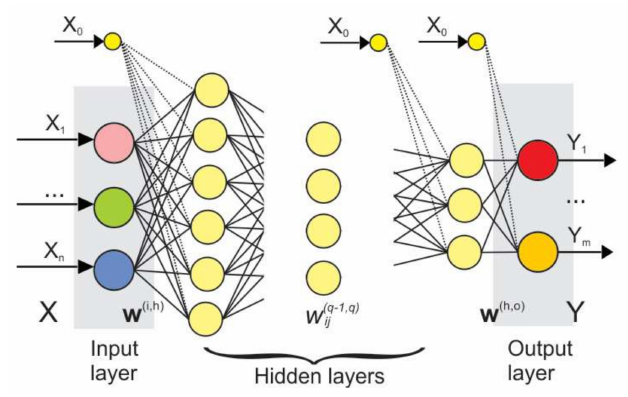
Figure 2. Schematic view of a feed-forward Artificial Neural Network (ANN).